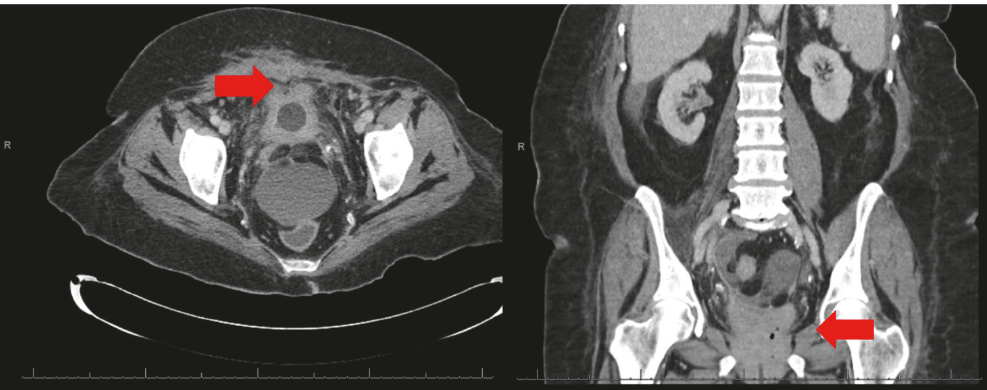
Figure 2: Extraperitoneal/intraperitoneal air with Foley catheter in place (arrow).